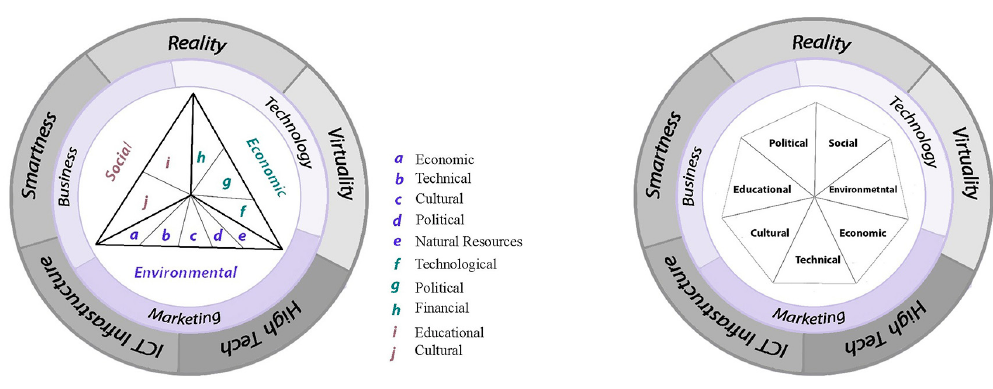
Figure 8. i-Sustainability Plus Theory (Prof. Dr. Hamid Doost Mohammadian, Figure 8. i- Sustainability Plus Theory (Prof. Dr. Hamid Doost Mohammadian, [8,21,44,45]).